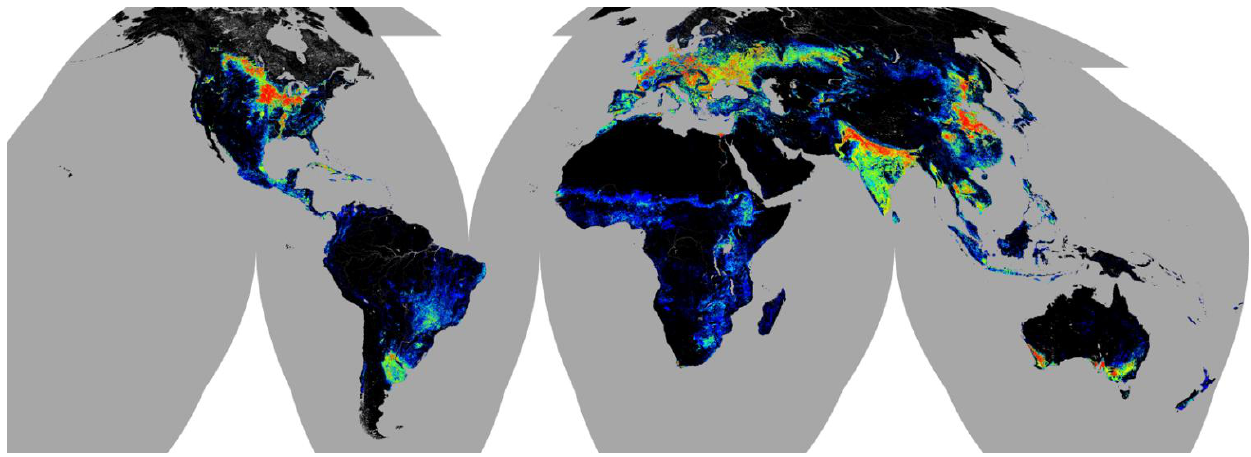
Figure 4. Agreement amongst five heritage cropland data sets, where red equals 5 out of 5 agreement, orange equals 4 out 5, green 3 out of 5, cyan 2 out of 5, and blue 1 out of 5. Each zone of agreement was converted to a mask for intercomparison with the MODIS 250 m cropland